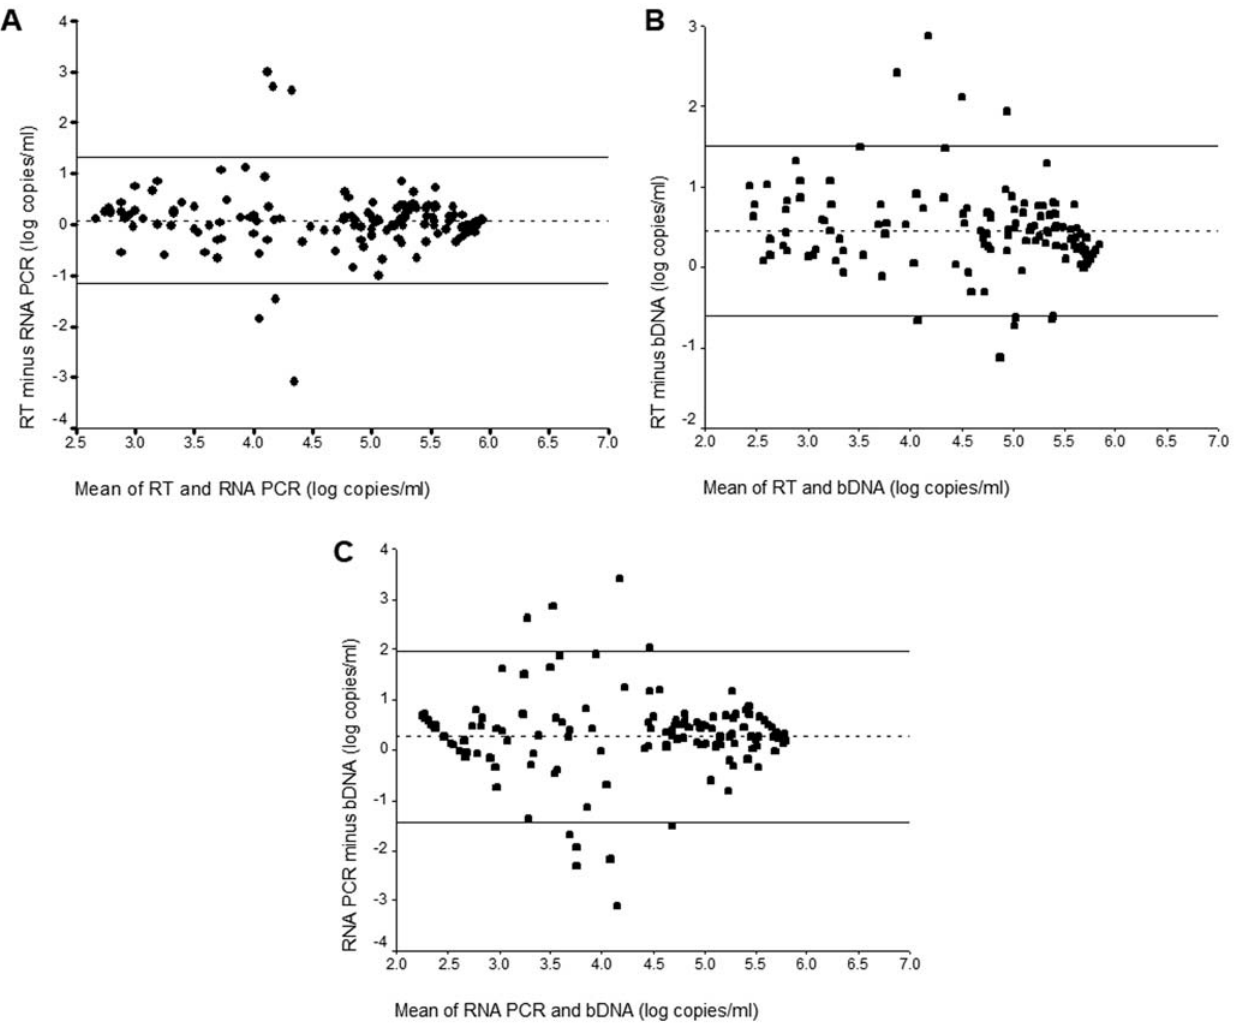
Figure 2. The measure of agreement between the RT assay and RNA PCR or bDNA assays is shown in the Altman-Bland plots. A. RT assay (equivalent log 10 copies/ml) and RNA assay (log 10 copies/ml); B. RT assay (equivalent log 10 copies/ml) and bDNA assay (log 10 copies/ml); and C. RNA assay (log 10 copies/ml) and bDNA assay (log 10 copies/ml). The dotted line represents the mean difference between values. Solid lines represent two standard deviations (2SD) (95% limits of agreement).